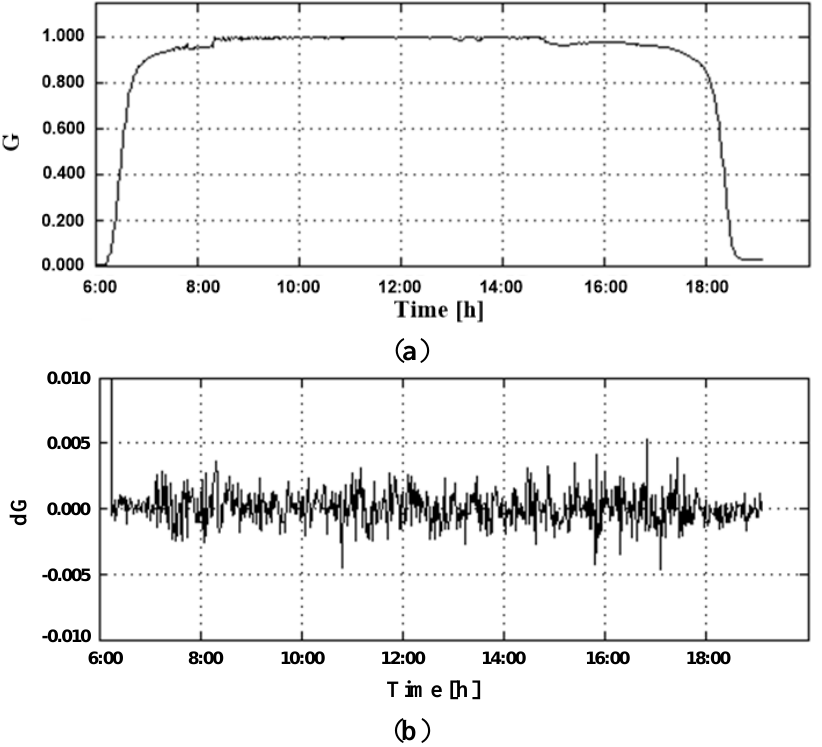
Figure 6. Input signal fuzzy controller ( a ) LDR series circuit response and ( b ) Variation of the LDR series circuit response.